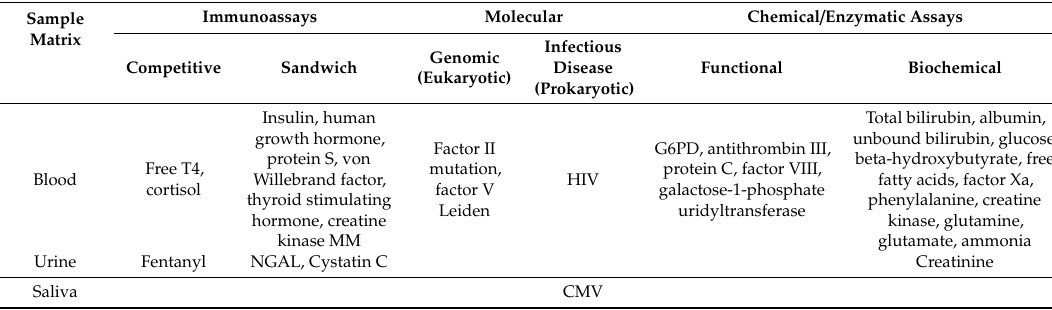
Table 2. Summary of assays adapted to the diagnostic DMF